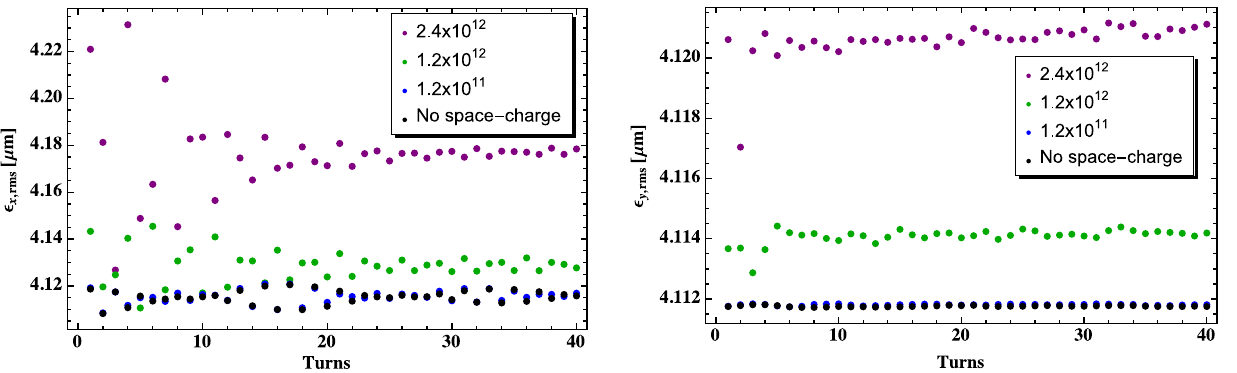
FIG. 22. Time evolution over the first 40 turns of the horizontal (left) and vertical (right) rms emittance for the 24-cell FODO lattice with 4 × 1 cell inserted straight sections with a working point of Q x =Q y ¼ 4 . 47 = 3 . 45 . The initial oscillation of the horizontal emittance decreases with intensity due to the decreasing dispersion